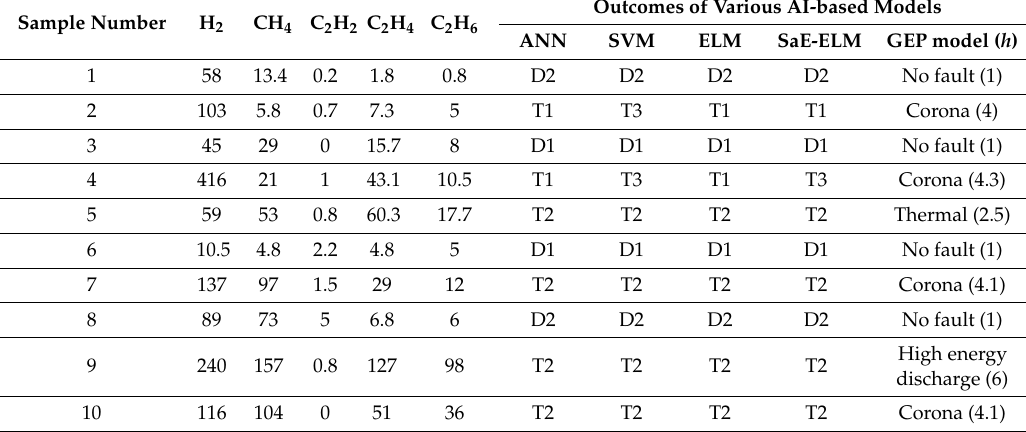
Table 5. Comparison of the GEP model with other AI-based models in